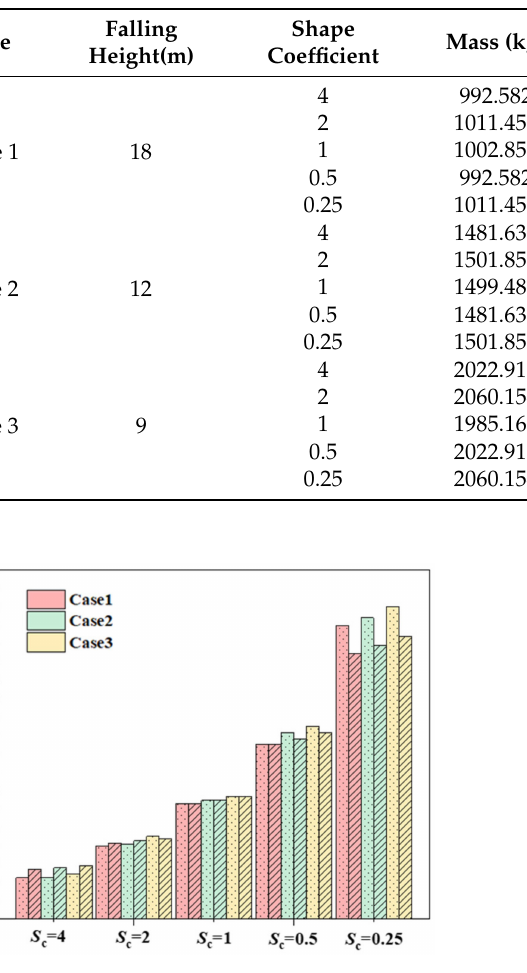
Figure 10. Comparison of large-scale simulation results and fitting results under three conditions. Speckles represent the results of numerical simulation, and diagonals represent the results obtained by Equation